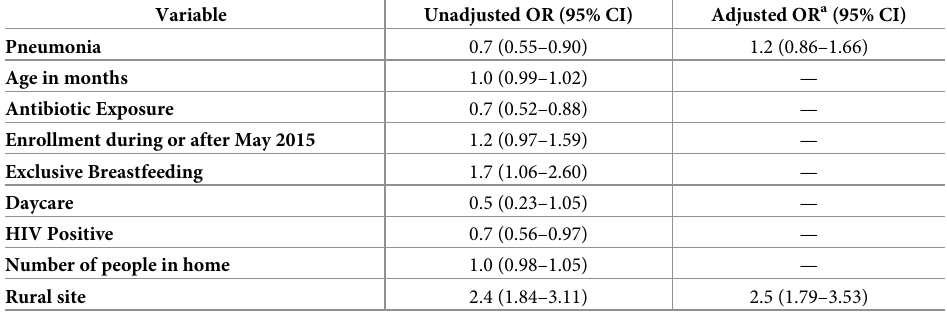
Table 2. Factors associated with overall pneumococcal colonization in children aged < 5 years in Manhic¸a and Maputo, Mozambique, 2014–2016. Variable